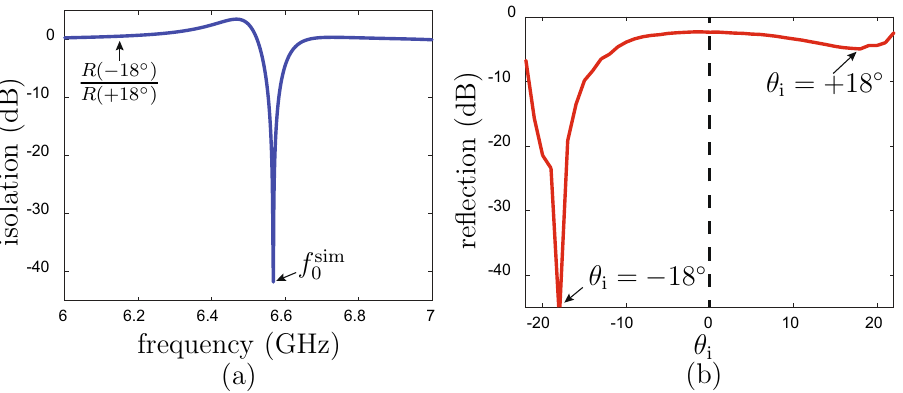
Figure 4. Full-wave simulation of the specular isolator with the unit cell in Fig. 3 and parameters p = 22.5 mm, w = 14 mm, l = 20 mm, v = 1.6 mm, d = 3.2 mm, q = 32.5 mm, h = 1 mm and t = 2 mm. ( a ) Isolation versus frequency for incidence at θ i = ± 18 ◦ (design angle of isolation). ( b ) Specular reflection coefficient versus incidence angle ( θ i ) at the operating frequency f sim 0 = 6.58 GHz.